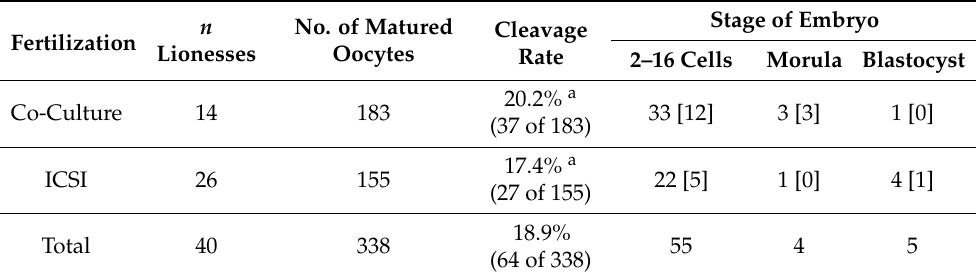
Table 4. Cleavage and embryo development as outcomes of fertilization method. Due to the low numbers, statistical analysis of embryo development was